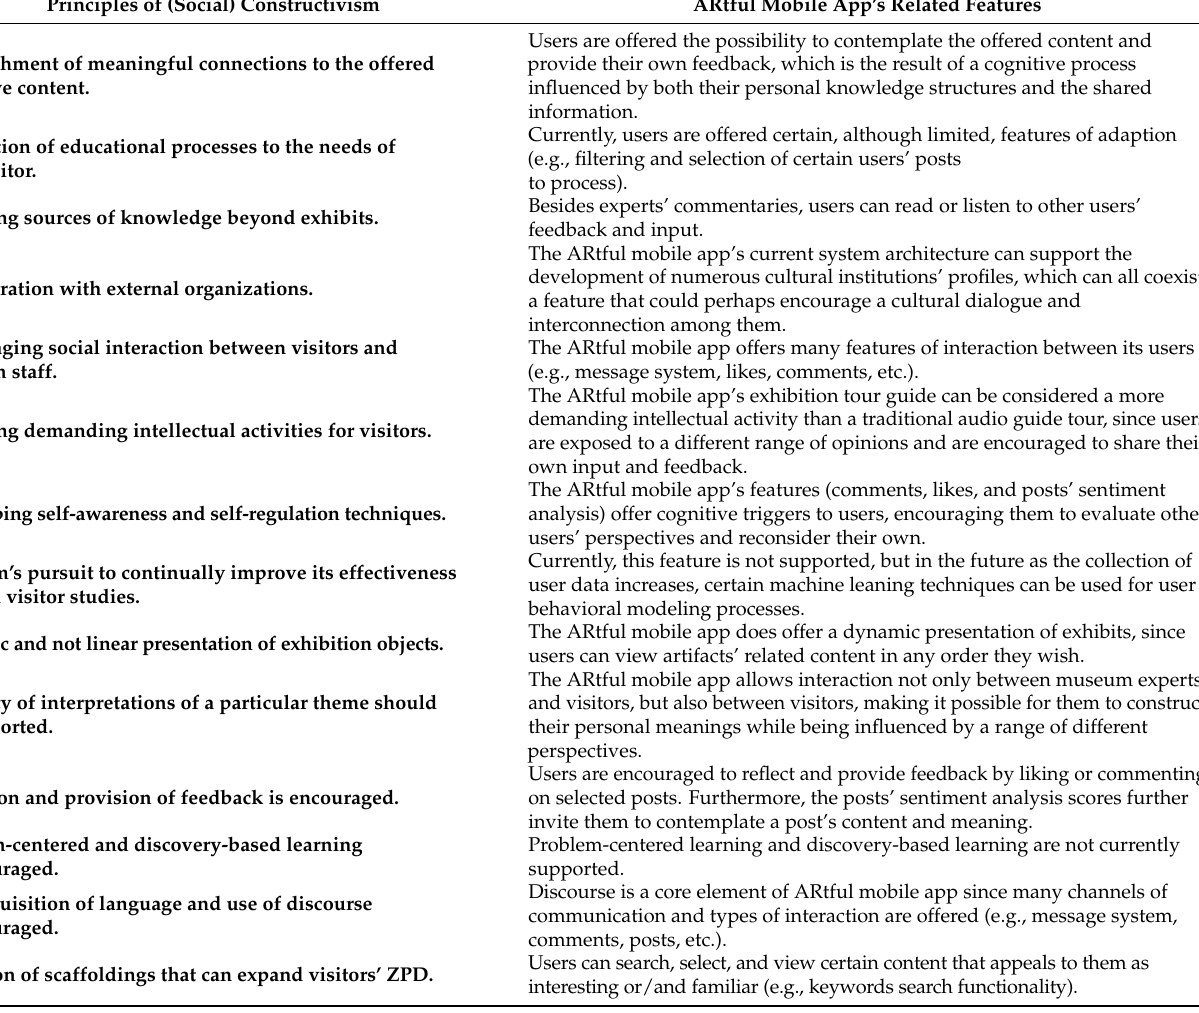
Table 1. Description of how the ARtful mobile app’s design and development were influenced by the key principles of the Constructivism and Social Constructivism learning